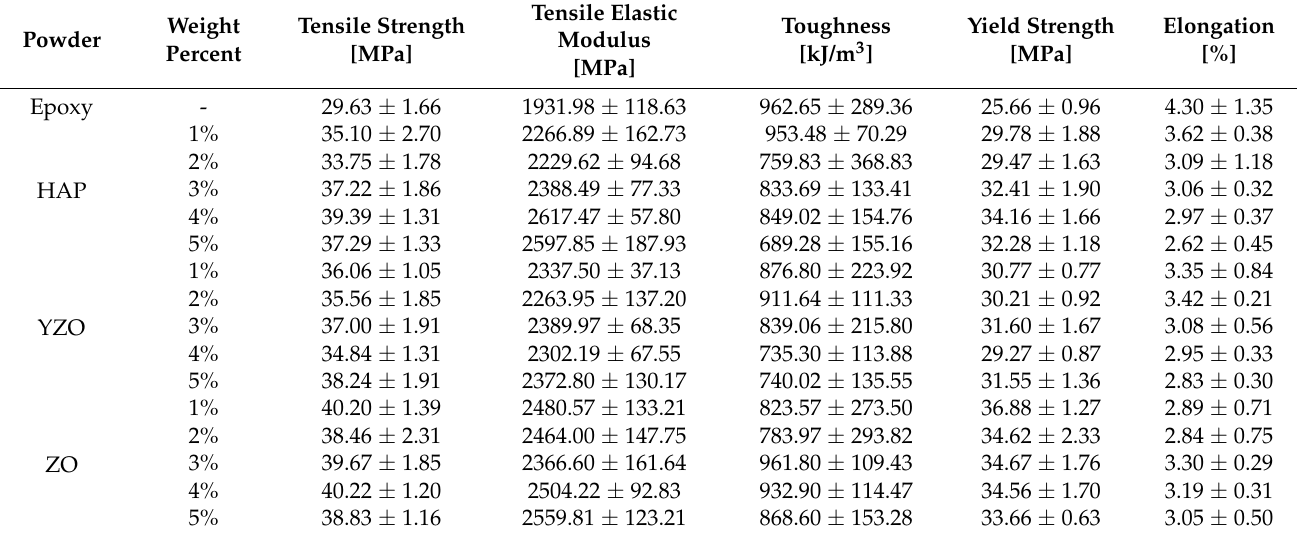
Table 3. Result of the tensile test by type of bioceramic–epoxy composite